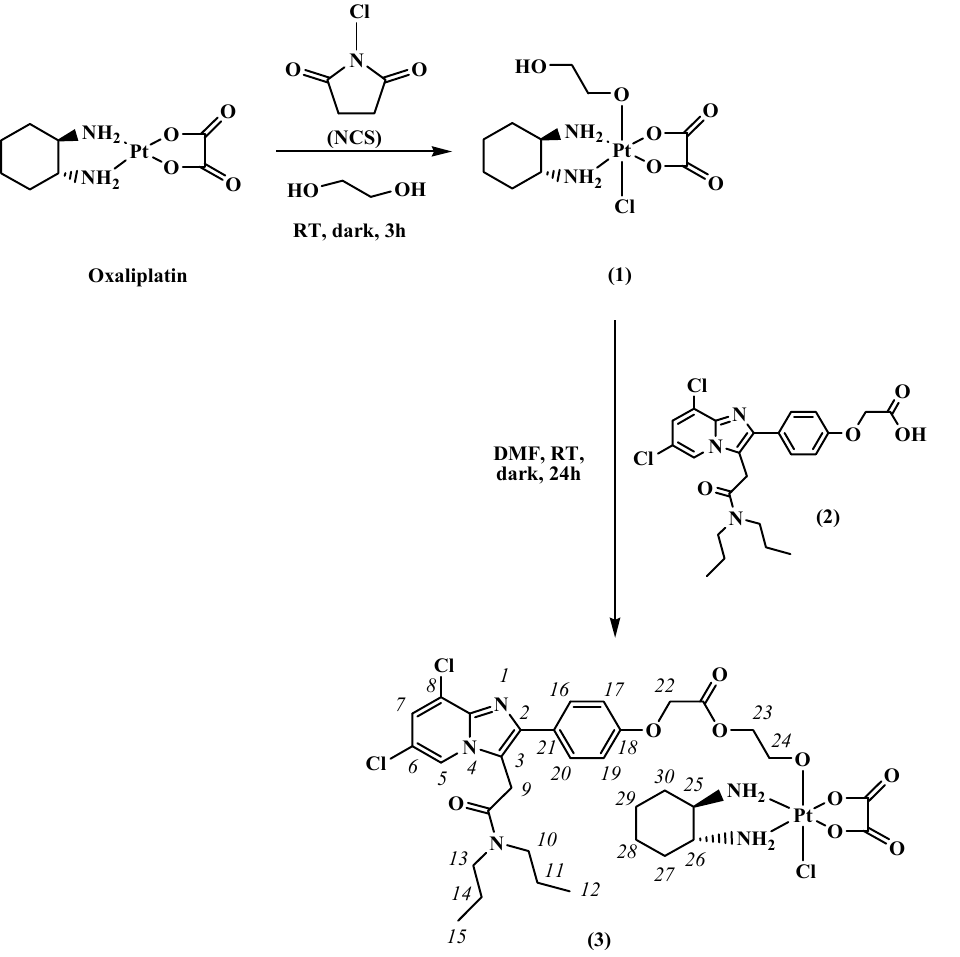
Figure 3. Synthesis of the novel Pt(IV) derivative of oxaliplatin with TSPO ligand in axial position ( 3 ) and numbering of protons. RT = room temperature. and numbering of protons. RT = room